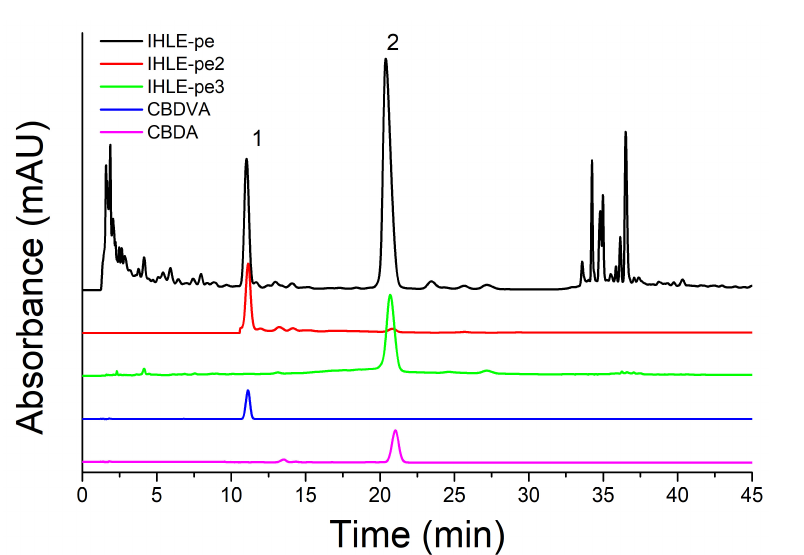
Figure 5. The chromatograms of IHLE-pe, IHLE-pe2, IHLE-pe3, CBDVA, and CBDA.